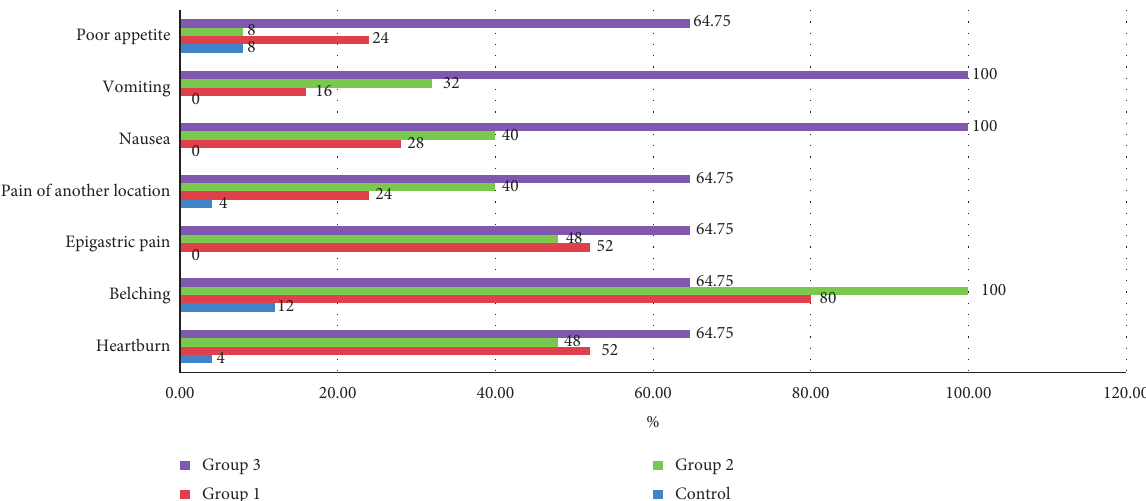
Figure 1: The comparative prevalence of esophageal complaints among patients with GERD with different types of refluctant.